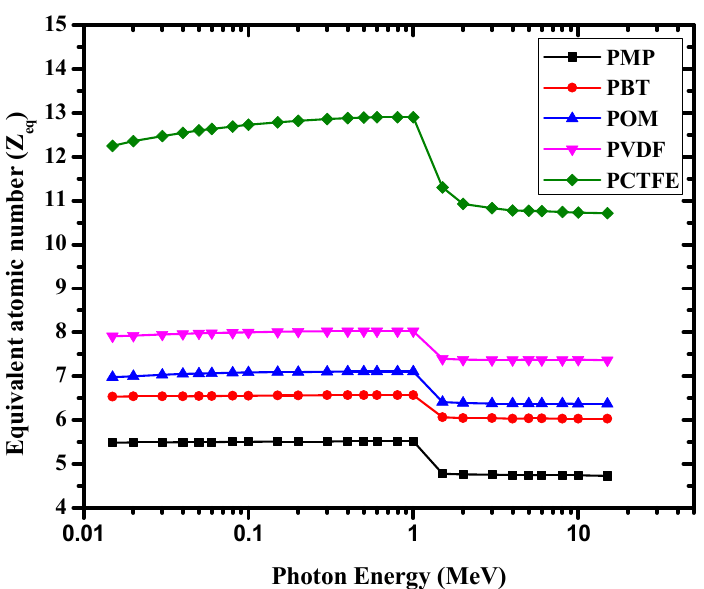
Figure 9. Z eq variation with different energy of photons for the investigated